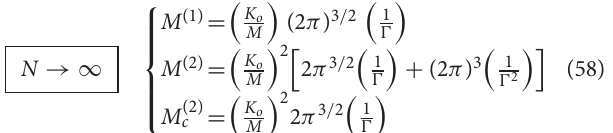
FIGURE 5 | Comparison between the analytical (full lines, from Equations 11, 55, and 56) and numerical (dots) results for the second central moment M (2) (black) and for the “non trivial” second central moment ˜ M (2) (blue) of the spectral density of states ρ ( λ ). The data at the indicated selected N values are reported as a function of the parameter Ŵ . The N values ( N = 50, 150, and 500 for the analytical case and 50 and 150 for the numerical one) are indicated on the black and blue curves. The red full line is the asymptotic, N reported in Equation (58), it turns out to be the same for M (2) and ˜ M (2) . The dashed red lines are the low Ŵ limit, reported in Equation